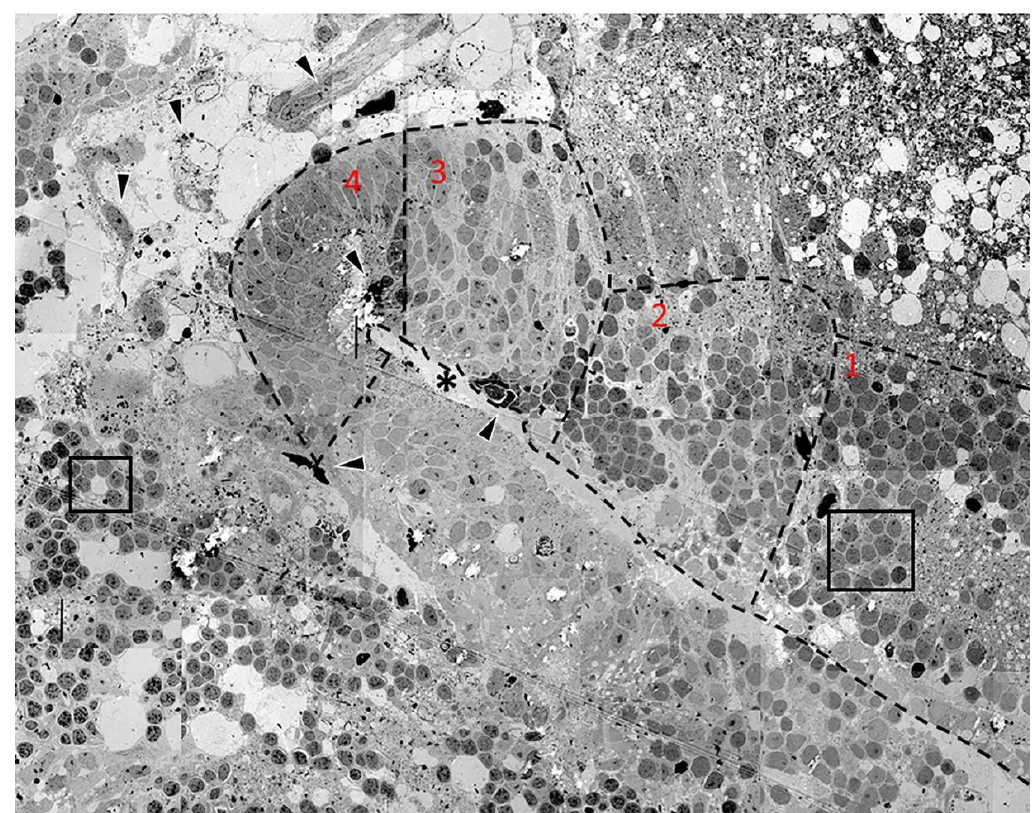
Figure 2. Electron microscopic panoramic overview of a folding embryoid embodiment in adult zebrafish optic tectum surviving in organotypic culture for 96 h. The image is a montage of 50 electron micrographs. Areas 1–4 represent cells differentiated to varying degrees, with area 4 representing the most highly differentiated cells. The central, organized region (asterisk) of the image, which is surrounded with spongiform degenerative regions (upper right corner) intermingled with signs of neovascularization and hematopoiesis (arrowheads) as well as rosettes (black boxes), represents early developmental formations. Inferior to the ventricular space, some mitotic cells can be recognized among differentiating nuclei.